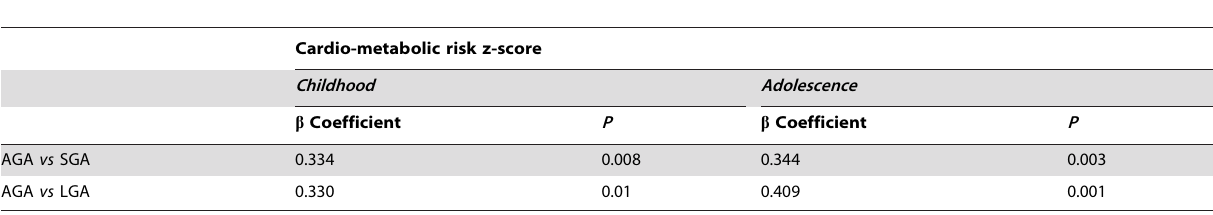
Table 2. Association between birth weight categories and cardio-metabolic risk z-scores during childhood and adolescence.